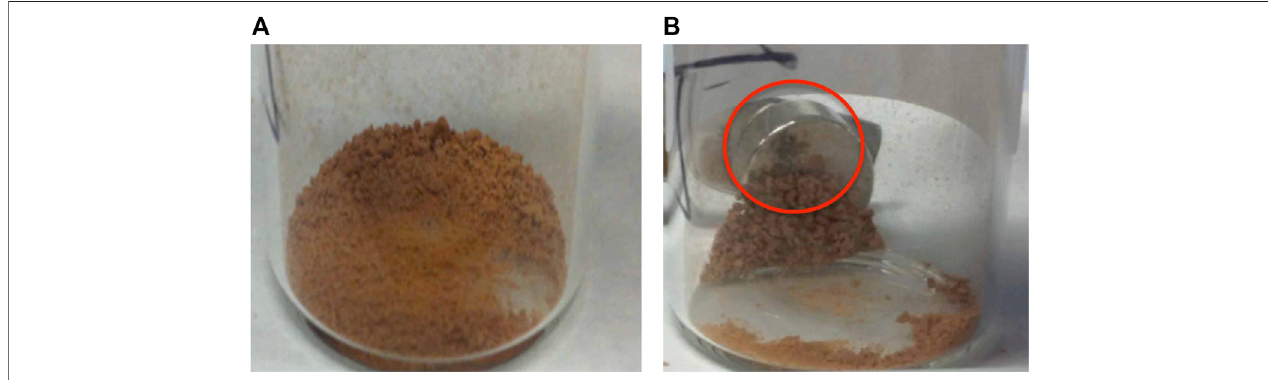
FIGURE 10 | Left (A) Photographs for the crude MS2 capsules, and Right (B) image showing the puri fi cation process occurring for MS2. The black powder highlighted by thered circle isthoughttoshow an area composed offreemagnetic nanoparticles, which are considered asimpurities thatcan be partitioned via multiple sweeps of an external magnet(s).